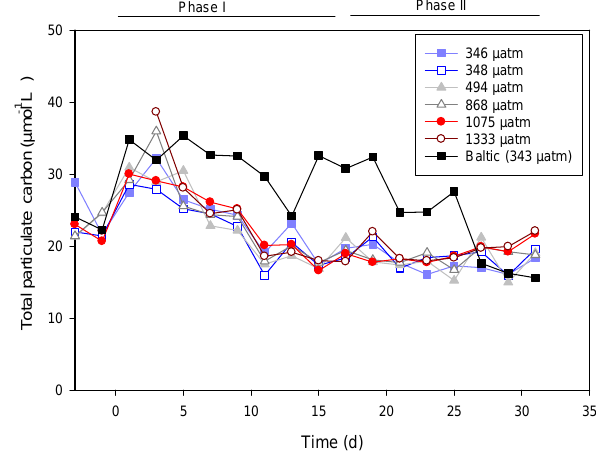
Fig 3. Figure 3. The development of TPC during the experiment. age microscope-derived carbon of TPC decreased from 26 % at t 0 to only ∼ 8 % of the measured TPC at t 31. These